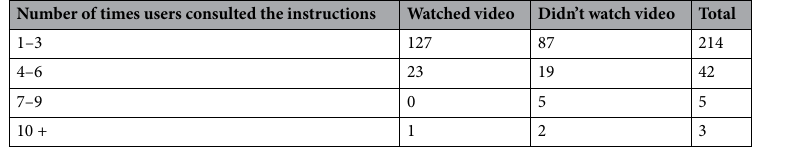
Table 3. Number of times the participants consulted the instructions for those watched the instruction video and those did not.